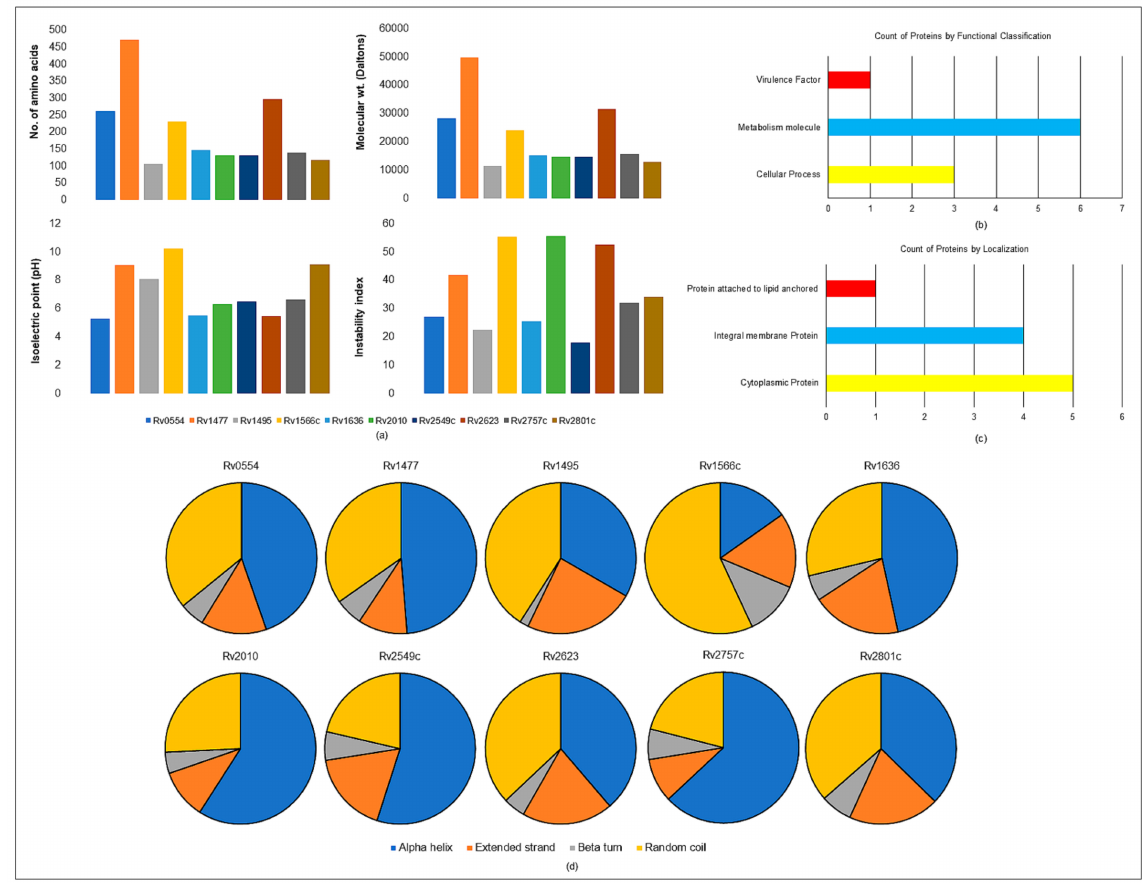
Figure 4. The selected virulence, detoxification, adaptation (VDA) category of M. tuberculosis H 37 Rv proteins. ( a ) Physiochemical parameters of VDA proteins ( b ) Functional classification of VDA proteins ( c ) Subcellular localization of VDA proteins and ( d ) Secondary structure analysis of VDA